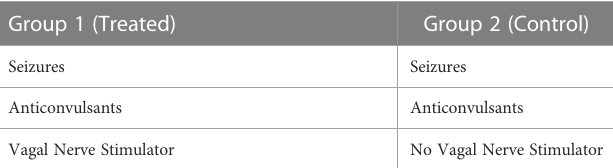
Table 1. A comparison of vagal nerve treated (n =4) and not treated (n = 4) seizure groups. Group 1